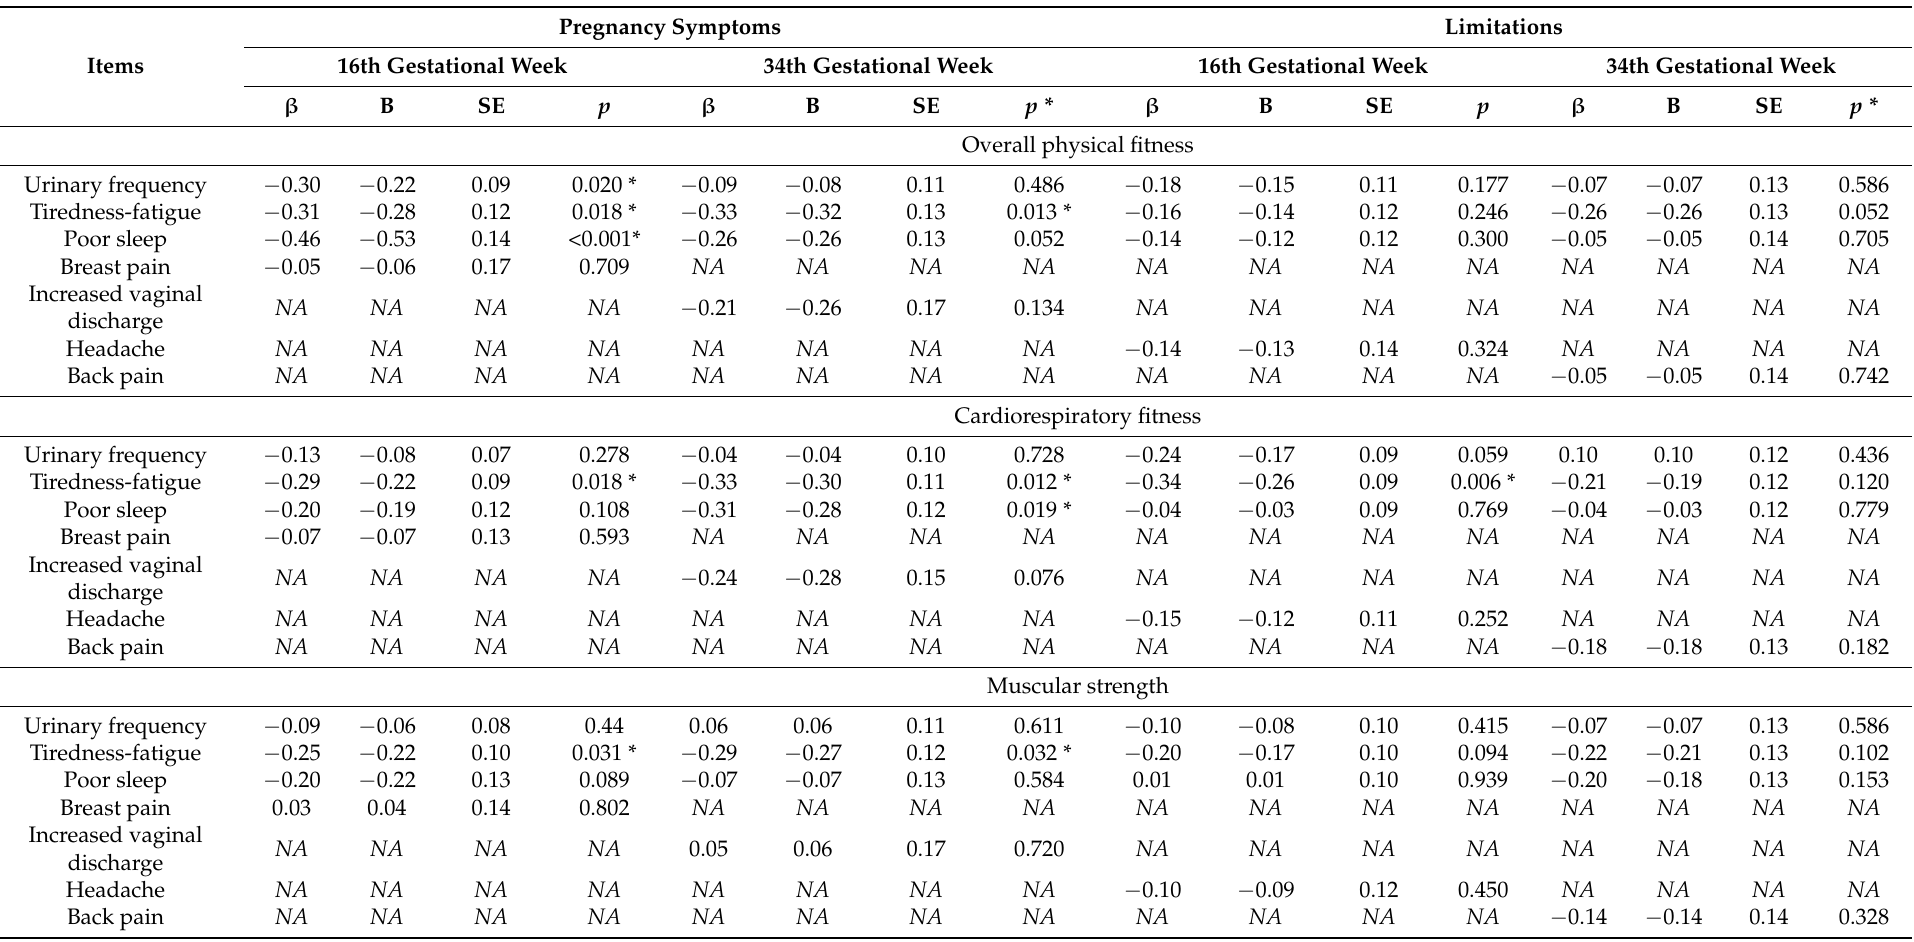
Table 2. Linear regression coefficients assessing the association of self-reported physical fitness and frequent symptoms and limitations at the 16th and 34th gestational